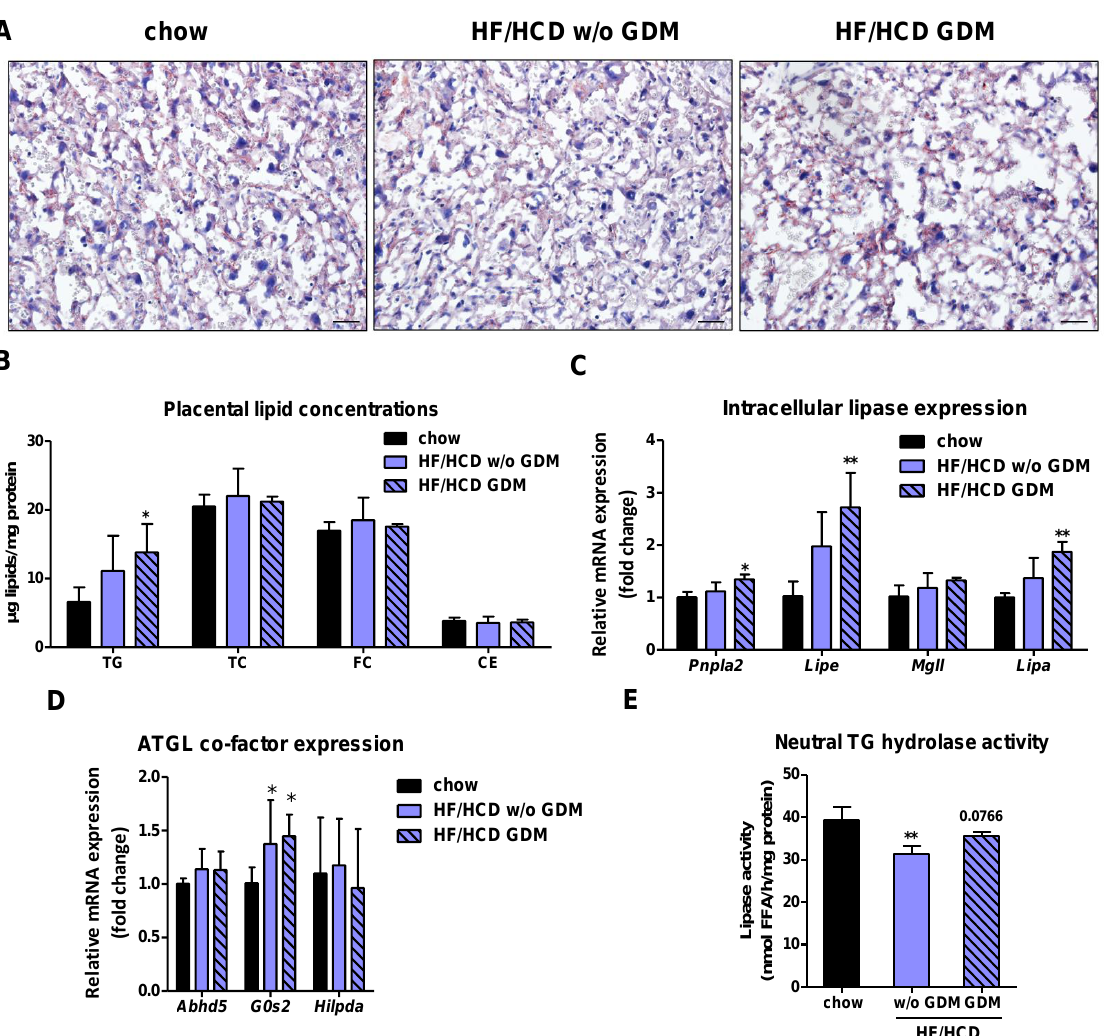
Figure 2. Decreased neutral TG hydrolase activity in placentae of HF/HCD-fed and GDM mice. Placental ( A ) oil red O staining and ( B ) lipid concentrations of chow, HF/HCD w/o GDM, and HF/HCD GDM mice ( n = 4 – 5). Scale bar, 100 µm. Gene expression of ( C ) lipases and ( D ) endogenous ATGL co-factors in placentae of these mice ( n = 4). ( E ) Placental TG hydrolase activity at neutral pH ( n = 5). Data represent mean + SD and were analyzed with 1-way ANOVA followed by Bonferroni post hoc test. * p < 0.05, ** p ≤ 0.01, indicating the comparison to the chow condition.